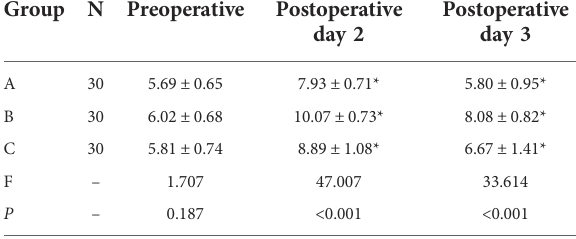
TABLE 6 Comparison of CRP levels among three groups